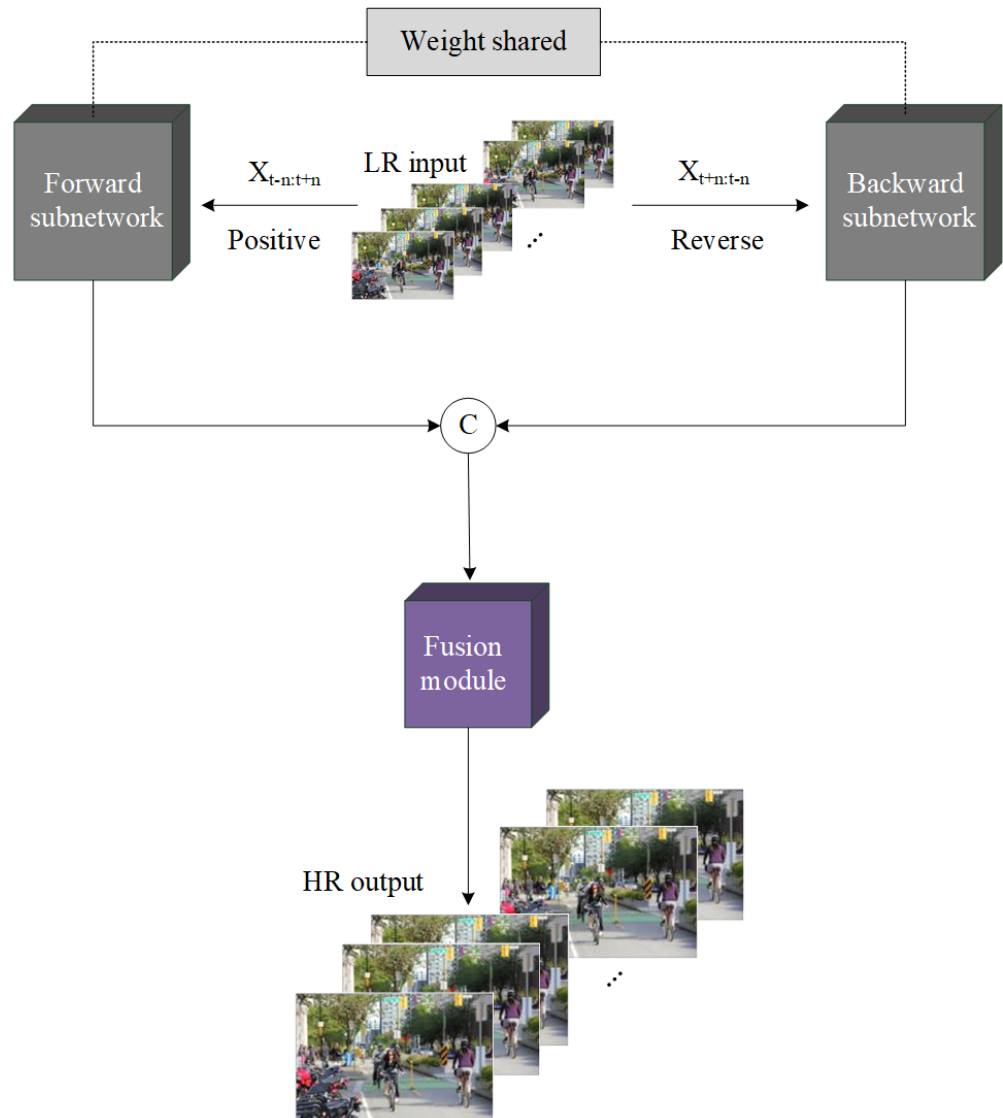
Figure 4. The bidirectional recurrent transmission